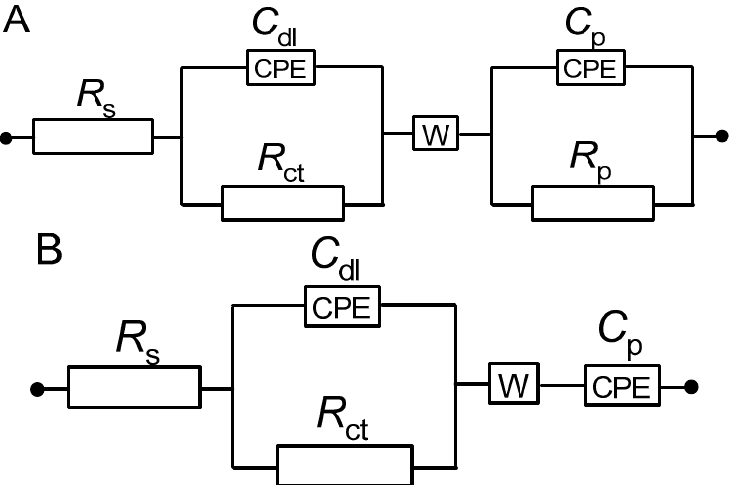
Figure 4. Equivalent circuit models used for fitting the obtained AC impedance spectroscopy data, where R s is solution resistance; C dl is double-layer capacitance; R ct is charge-transfer resistance parameter for electrooxidation AM dye molecule; W is Warburg element used to account for finite-length diffusion; ( A ) R p and C p are porosity resistance and pseudocapacitance parameters, respectively; ( B ) C p is the pseudocapacitance parameter. In addition, the circuits include constant phase elements (CPEs) to account for the distributed capacitance.